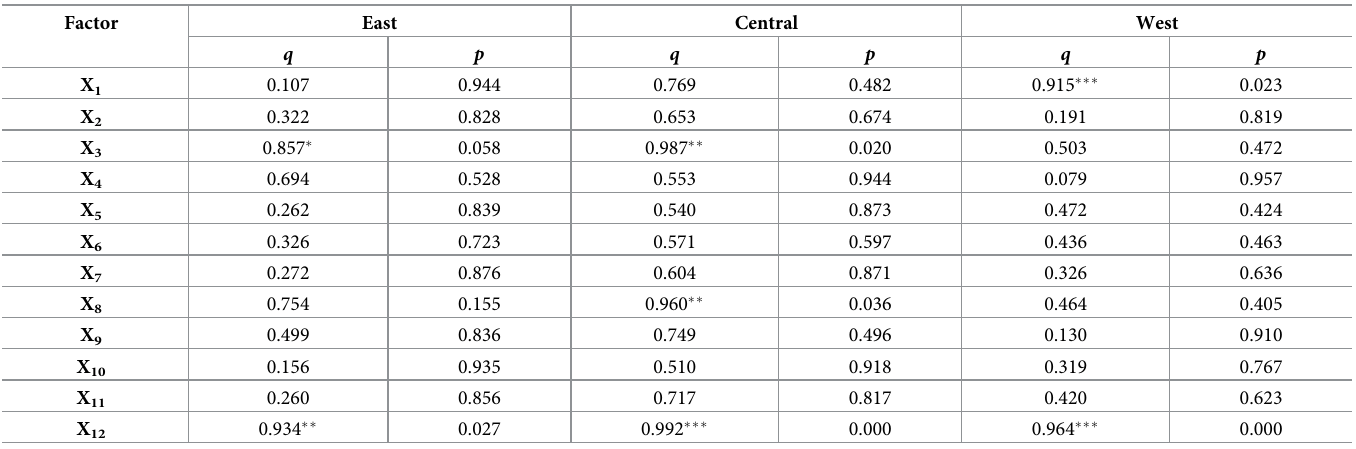
Table 5. Sub–regional internet attention factor detection